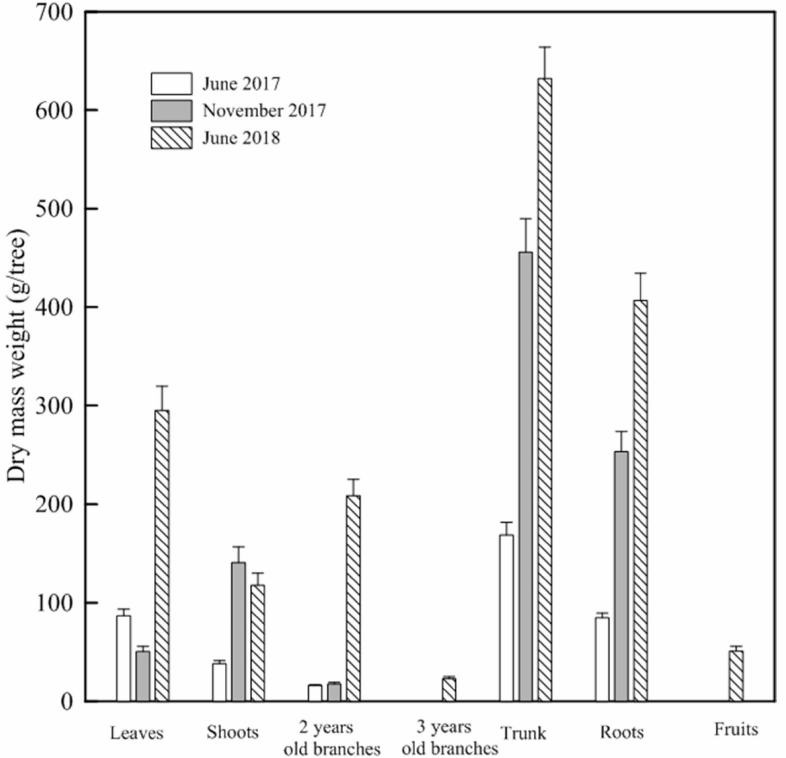
Figure 2. The dry mass weight of each organ during different stages. Vertical bars represent one standard deviation of the mean ( n = 6).